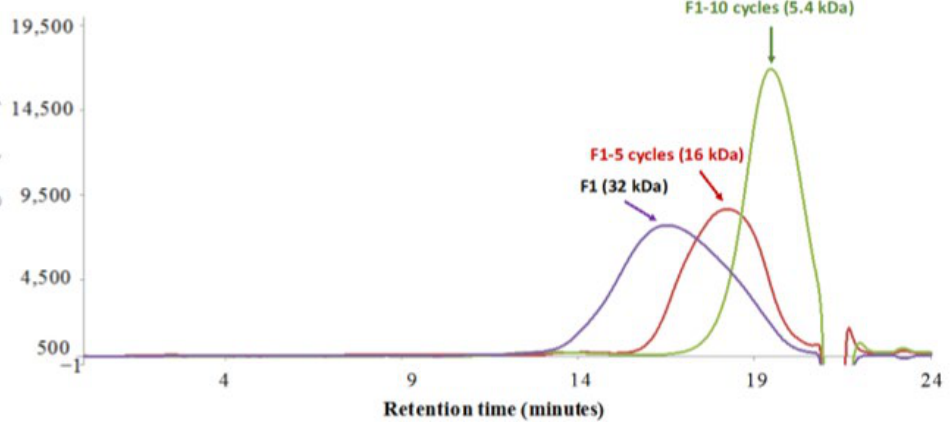
Figure 2. HPLC/SEC analysis (on TSK Gel 5000/3000 PWXL placed in serial) of depolymerized fungal chitosan (fraction F1) via an acetic acid/autoclaving process. The average molecular weight was determined using a calibration curve of pullulan standards.